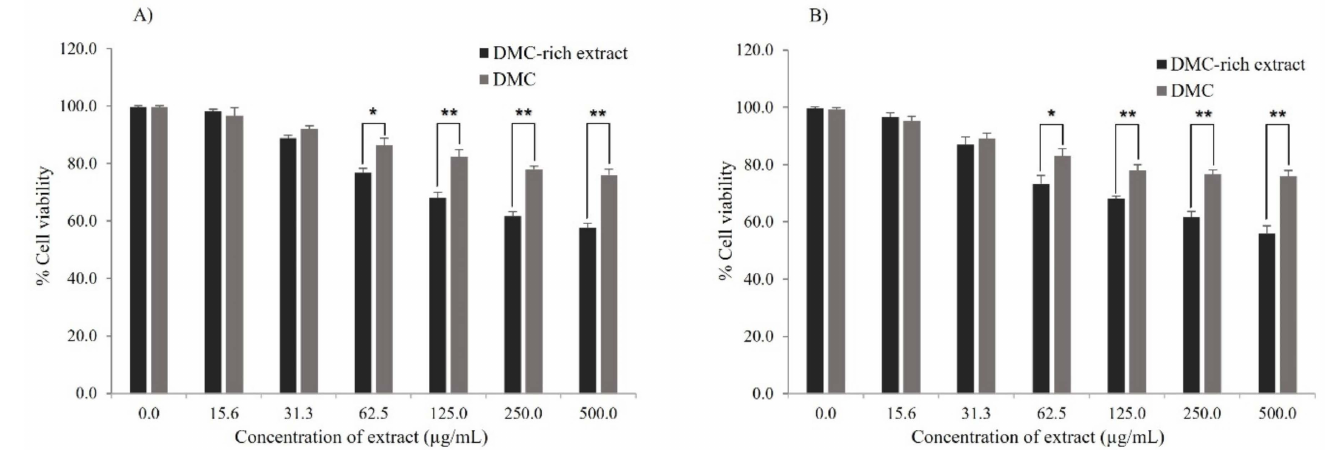
Figure 6. The effects of DMC-rich extract and DMC of S. nervosum on HepG2 cell viability at ( A ) 24 h and ( B ) 48 h. The data are an average of %cell viability ± SD of three studies. * p < 0.05 and ** p < 0.01 define statistically significant